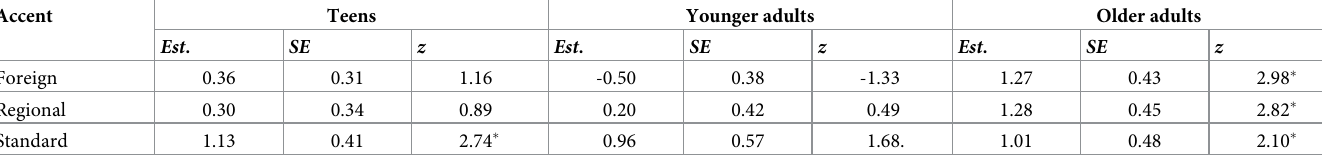
Pairwise contrasts for accentedness ratings between the Asian and white European ethnicity within each group and accent. Coefficients (Est.), standard errors (SE), and z-values were extracted from the cumulative link mixed model (Tukey adjusted for multiple comparisons). � p < .05, . p <